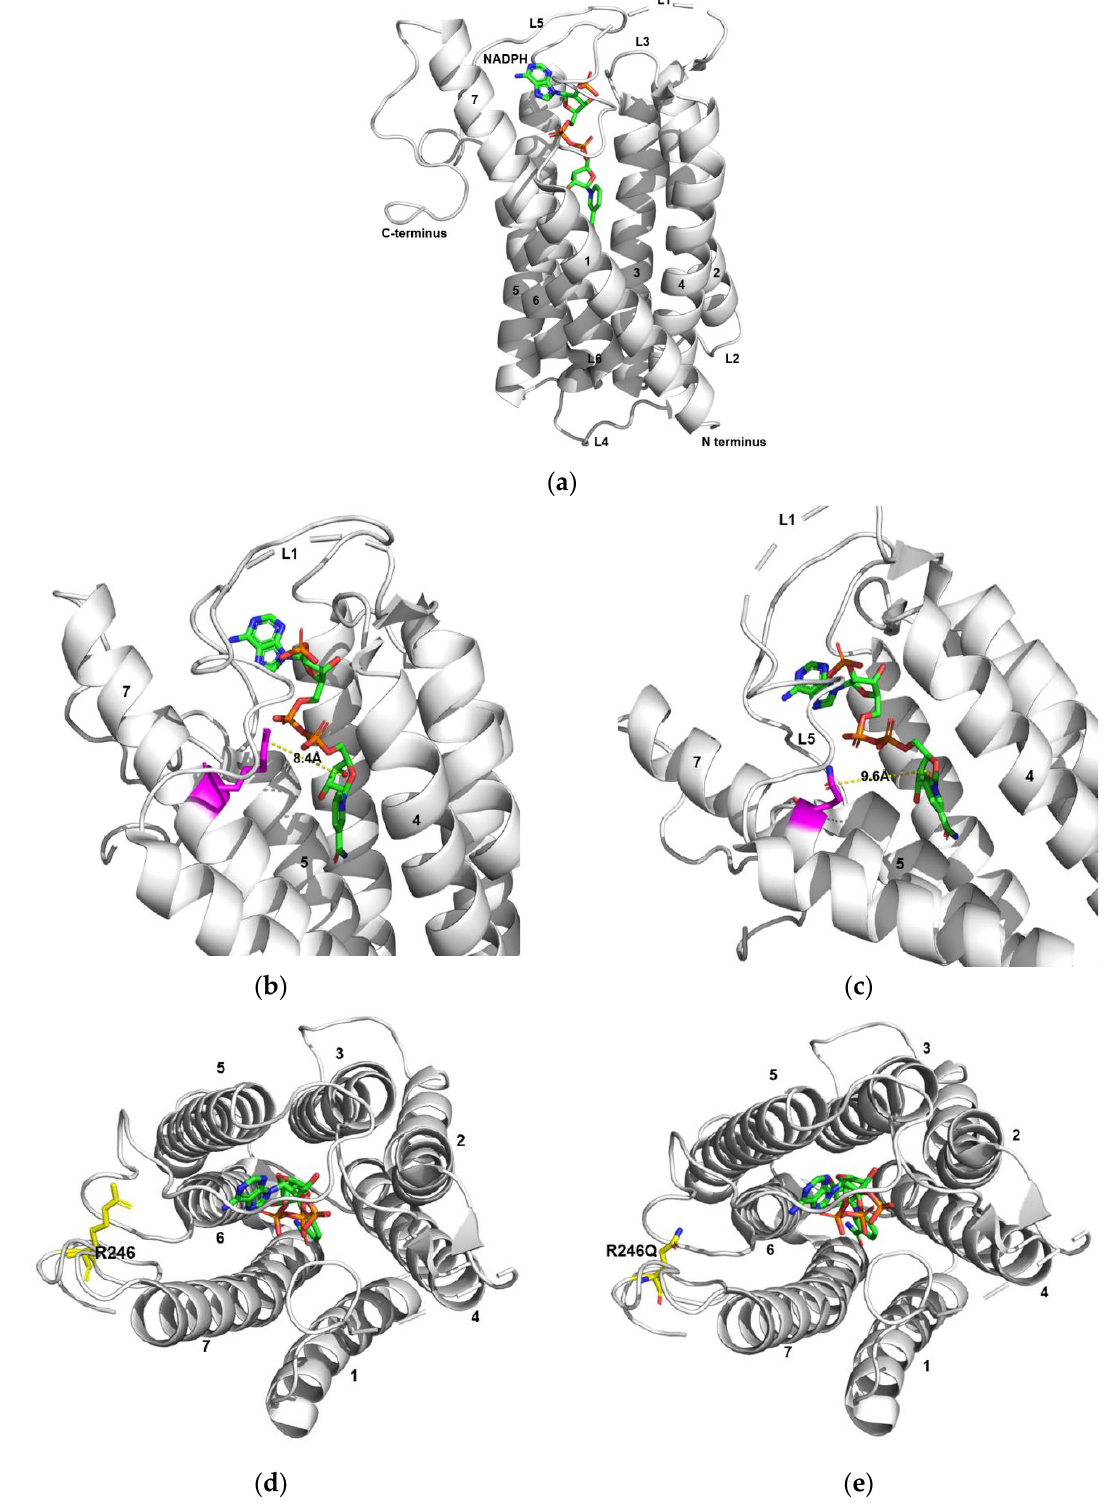
Figure 4. Overall structures of human SRD5A2 and NADPH. ( a ) Vertical perpendicular view of the SRD5A2-NADPH complex structure. ( b ) The distance from NADPH when p.227 is arginine (R) (wild-type). ( c ) Distance from NADPH when p.227 is glutamine (Q). ( d ) Horizontal perpendicular view of the SRD5A2 structure with the wild-type p.246 and NADPH. ( e ) Horizontal perpendicular view of the SRD5A2 structure with the p.R246Q variant and NADPH from the top.